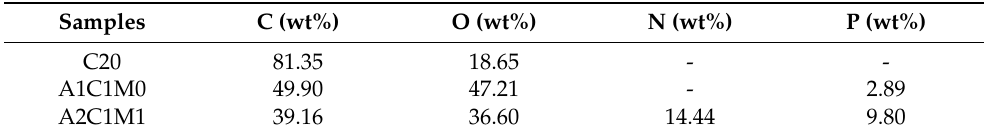
Table 3. EDX results of residues for flame-retardant PLA composites after LOI test.